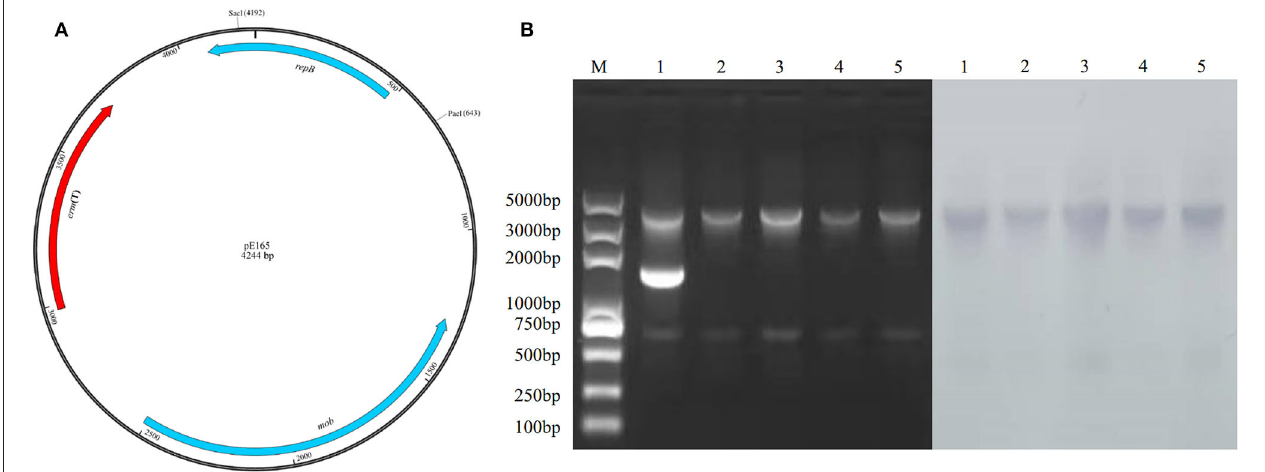
FIGURE 3 | (A) Restriction enzyme cutting sites of Sac I and Pac I on pE165. (B) Restriction enzyme-digested plasmid profiles treated by Sac I, Pac I, and southern blot using erm (T) gene as the probe. M: marker 1; E. faecalis E165, 2; E. faecalis OG1RF-Tc, 3; S. mutans UA159-Tm, 4; S. suis P1/7-Tm, 5; S. aureus RN4220-Tm. The upper and lower bands were the fragments of pE165 digested by Sac I and Pac I. The middle band in line 1 was supercoiled pE165-3.